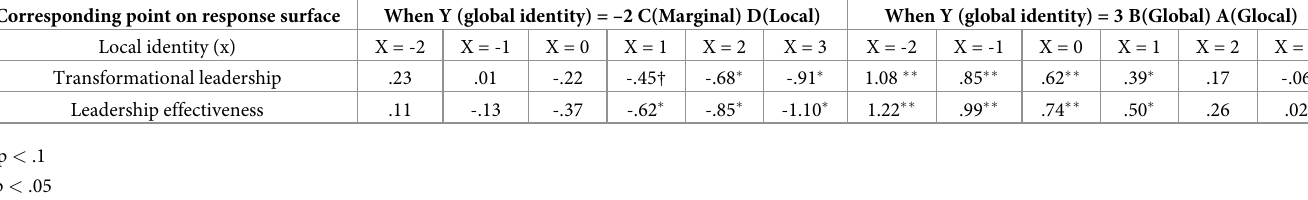
Table 5. Wald tests for slopes of tangents along edges of response surfaces. Corresponding point on response